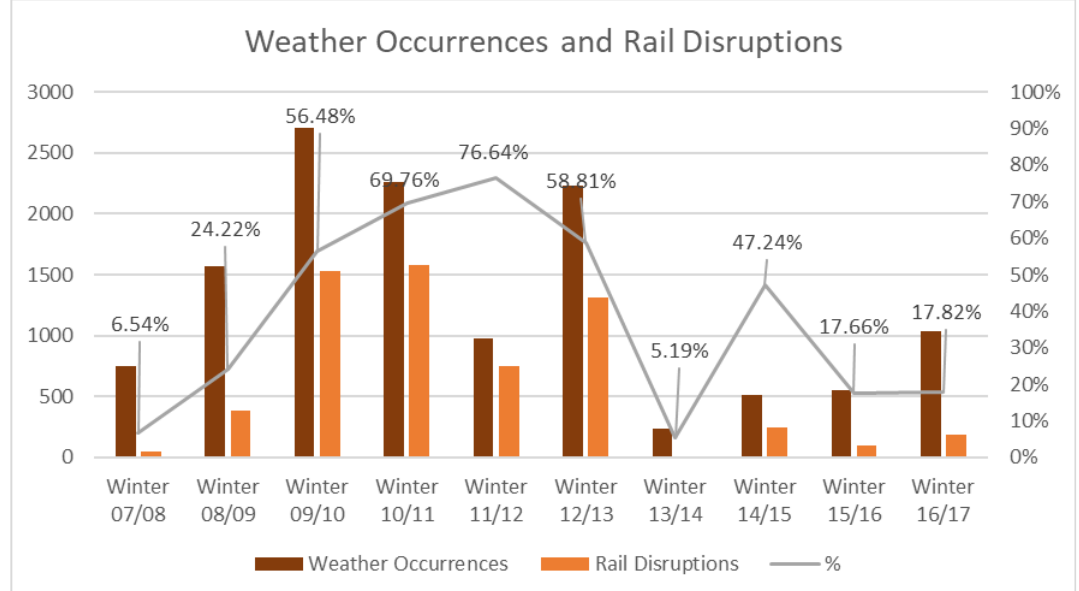
Figure 3 Distribution of winter weather occurrences and winter-related